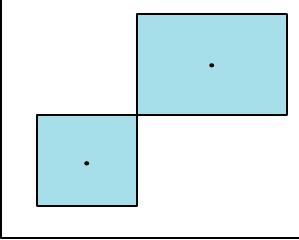
Figure 10. A case with non-contiguous departments.